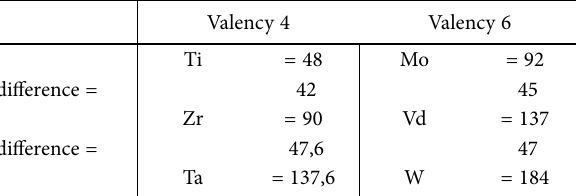
Figure 3. Groups of six elements with the difference of nearly 46 of atomic weights and the valency four and six. Adapted from